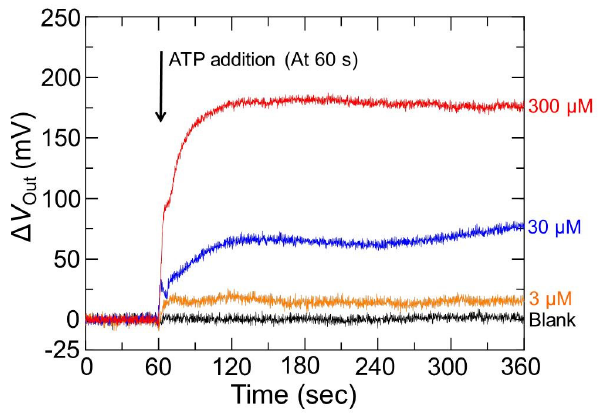
Figure 7. Characteristics investigation of output response after 1 mM − ATP was added to the sensor. (a) Typical Δ V Out − time curve to ATP measured by the enzyme − immobilized sensor, (b) time re- sponse of an enzyme − free sensor, and (c) time response of enzyme − immobilized sensor measured in no glycerol. Working buffer is 10 mM − HEPES at pH 7.4.